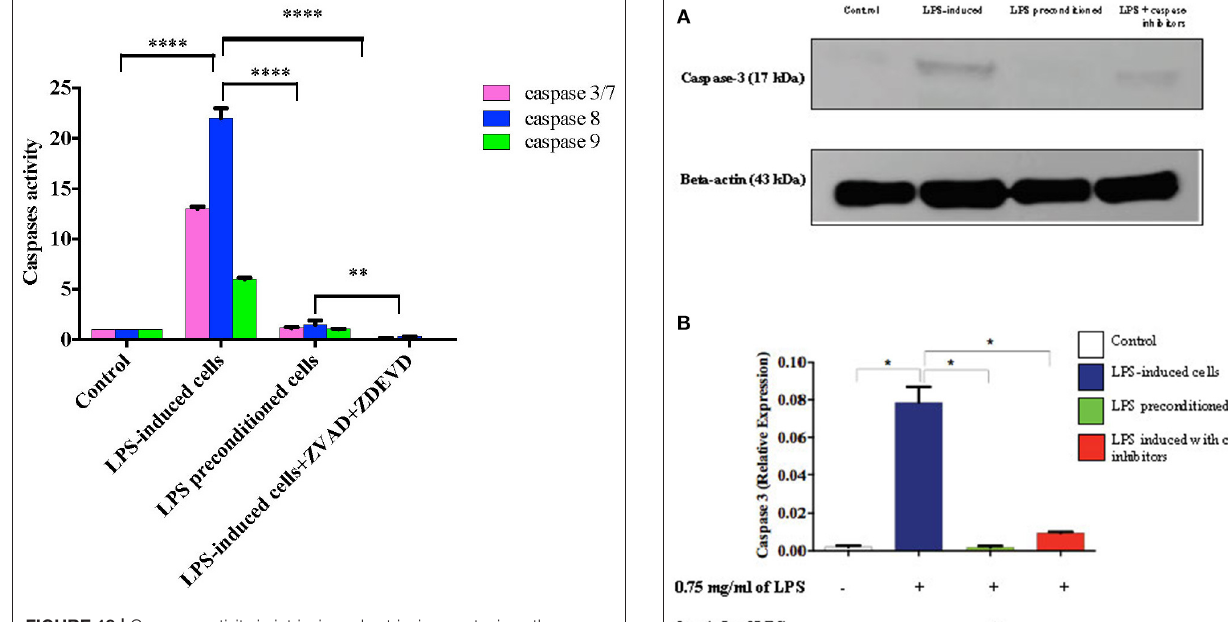
FIGURE 18 | Caspase activity in intrinsic and extrinsic apoptosis pathway. Fold changes in caspase 3/7, caspase-8, and caspase-9 activities in LPS-induced cells, LPS-preconditioned cells, and LPS-induced cells with caspase inhibitors compared to control cells based on the relative luminescence units generated through the cleavage of substrate after treatment. Data were analyzed using two-way ANOVA, followed by a Bonferroni post-hoc test, ** p < 0.01 **** p < 0.0001 vs. control cells. Data are expressed as mean ± S.E.M of three independent experiments.